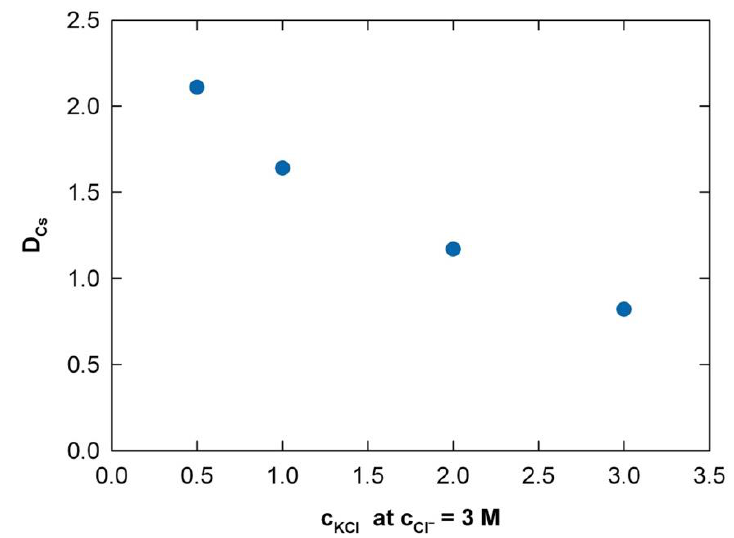
Figure 7. Cs + distribution ratios as a function of KCl concentration at a fixed chloride concentration. Organic phase, 0.025 M MAXCalix in 1-octanol/kerosene 75/25. Aqueous phase, 3 M (K, Na)Cl + 0.001 M HCl + 137 Cs (10 kBq/mL). Table 4. Cs + extraction and stripping distribution ratios for 3 different organic phases. Aqueous phase (extraction), 4 M MgCl 2 , 1 M KCl, 0.3 M NaCl, 0.2 M MgSO 4 , 1 mM CsCl + 0.001 M HCl. Aqueous phase (stripping), 0.01 M